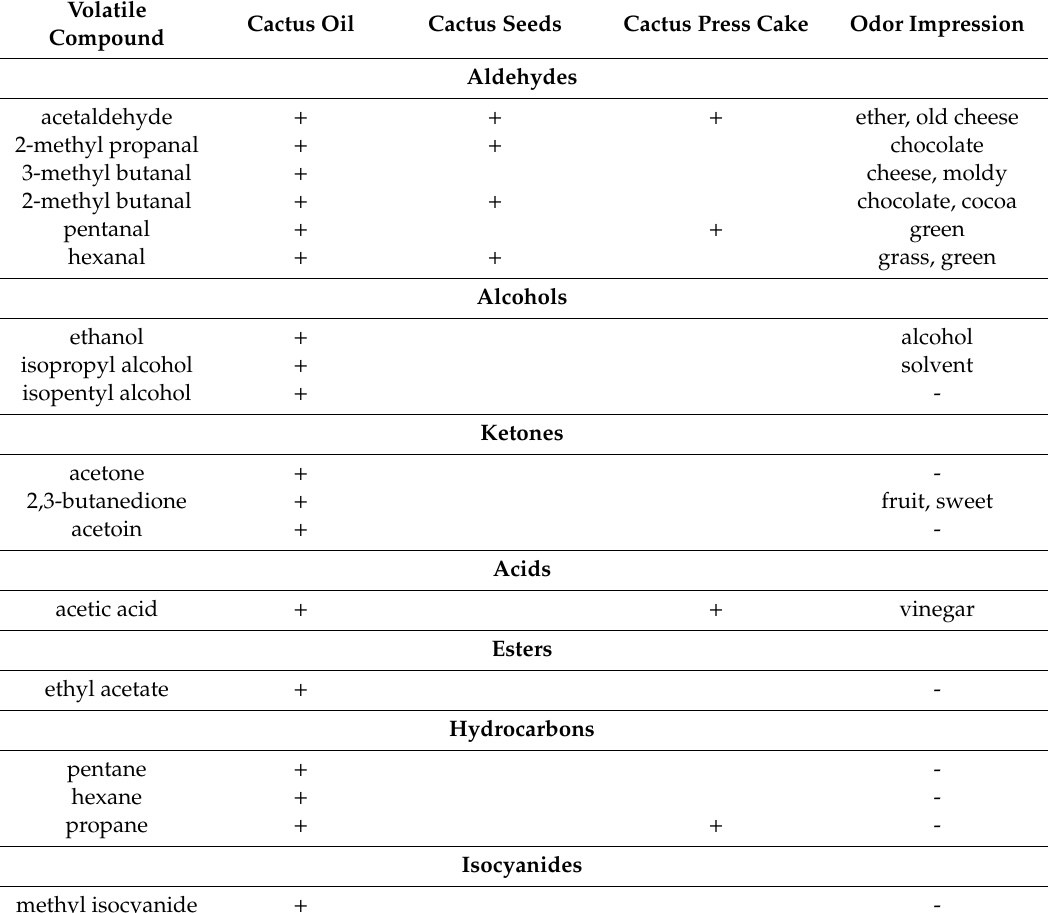
Table 1. Occurrence of volatile compounds of cactus seed oil, cactus seeds, and cactus press